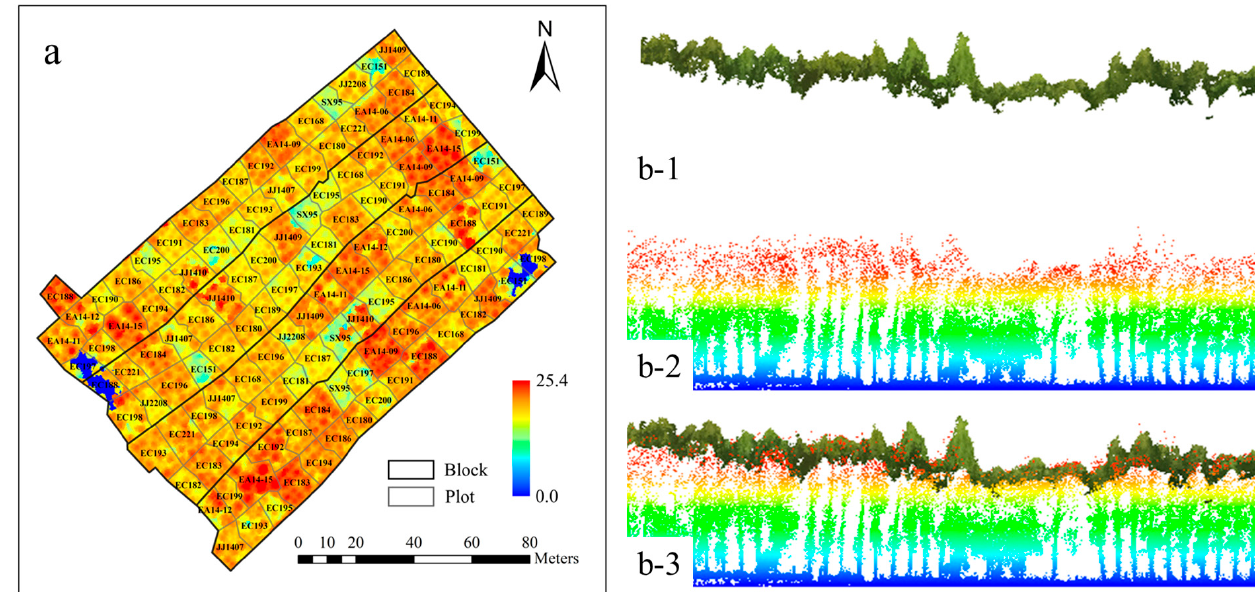
Figure 3. Canopy height model (CHM) ( a ) and comparison of DAP point cloud profile with backpack LiDAR point cloud profile ( b ). After the DAP point cloud was registered with the backpack LiDAR, the backpack LiDAR was used to extract ground points and generate a DEM, and then CHM was generated by a normalized DAP point cloud. From top to bottom on right, the profile shows normal- ized DAP point cloud ( b-1 ), normalized backpack LiDAR point cloud ( b-2 ), and their superposition ( b-3 ). The DAP point cloud is displayed in RGB, and the backpack LiDAR point cloud is displayed in